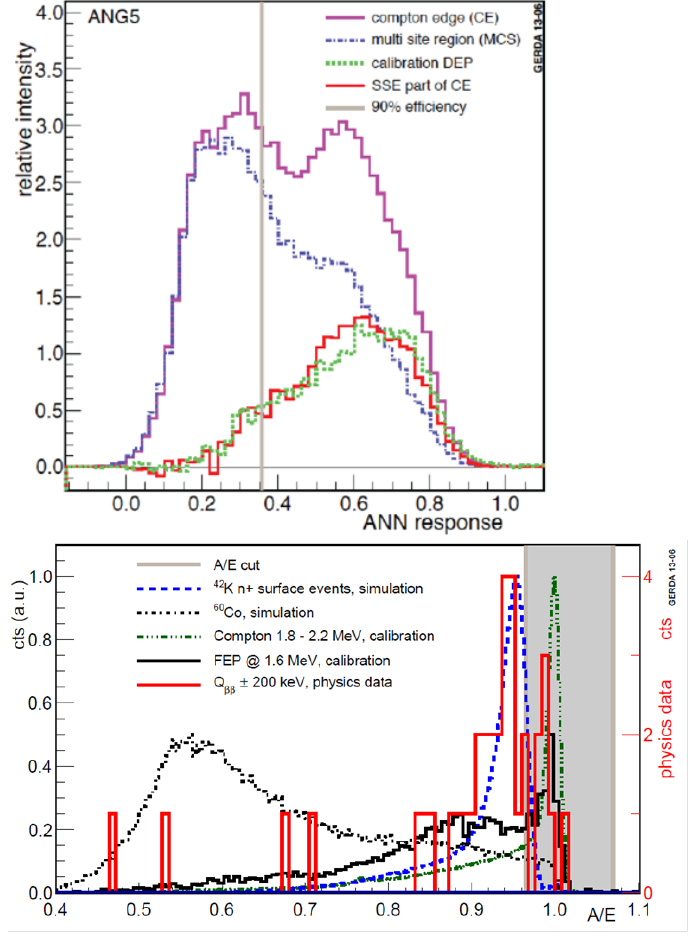
Figure 11. The PSD estimator for different SSE and MSE event classes for one C OAX ( top ) and one BEG E ( bottom